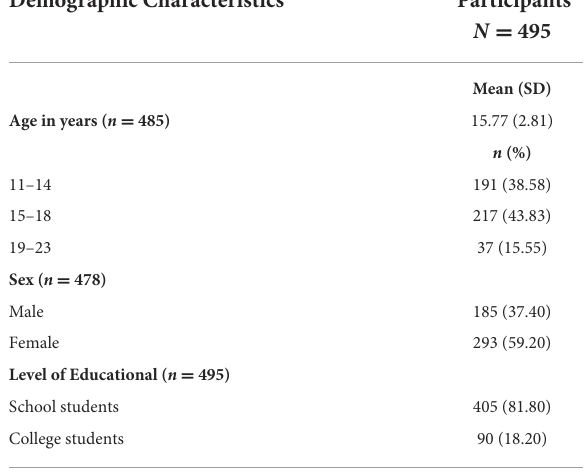
TABLE 1 Demographic sample